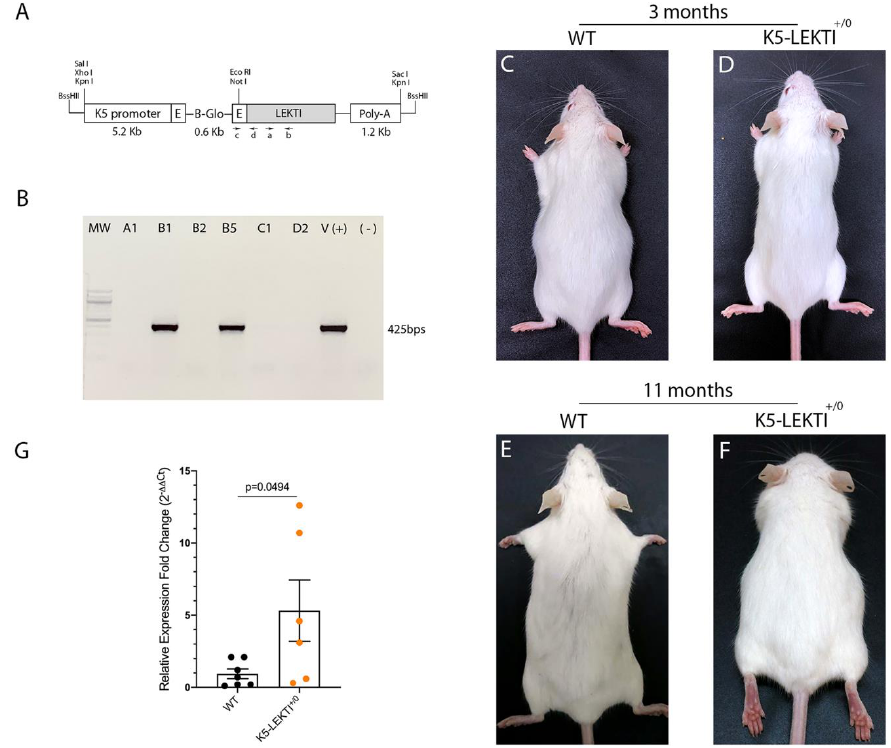
Figure 2. Generation of Keratin5-LEKTI transgenic mice. ( A ) Schematic structure of the K5-LEKTI transgene comprised of a bovine keratin-5 promoter (K5), rabbit-globin exons, a rabbit-globin intron, the mouse LEKTI cDNA and a rabbit-globin polyadenylation signal (PolyA). (a,b) position of primers used for qPCR and (c,d) genotyping. The linearized transgene vector was microinjected into the male pronucleus of FVB/NJ zygotes, which then were implanted into pseudopregnant mice. ( B ) LEKTI transgenic founders were genotyped by PCR using genomic DNA from tail biopsies with the primer pair indicated on the vector (c,d). Genotyping gel showing positive 425 bps amplified bands from founder mice. pBK5-LEKTI vector was used as template for positive control. ( C − F ) Images of 3 ( C , D ) and 11 months ( E , F ) old WT ( C , E ) and K5- LEKTI +/0 ( D , F ) mice showing no differences on the outward phenotype. ( G ) qPCR analysis of the epidermis of newborn WT (black dots) and K5-LEKTI +/0 (orange dots) mice show a five-fold increase of LEKTI mRNA expression in transgenic compared to WT mice. WT n = 7 and K5-LEKTI +/0 n = 6; values are expressed in mean ± SD . p -values (two-tailed unpaired parametric t -test) are displayed in the graph.